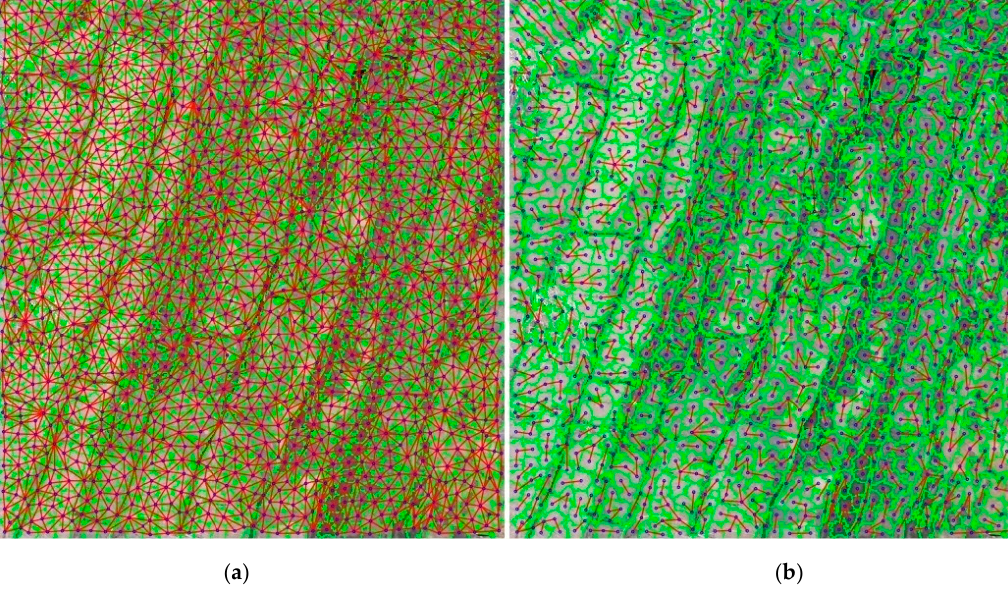
Figure 21. ( a ) The RAG of the superpixel segmentation result; ( b ) The NNG of the superpixel segmentation result.